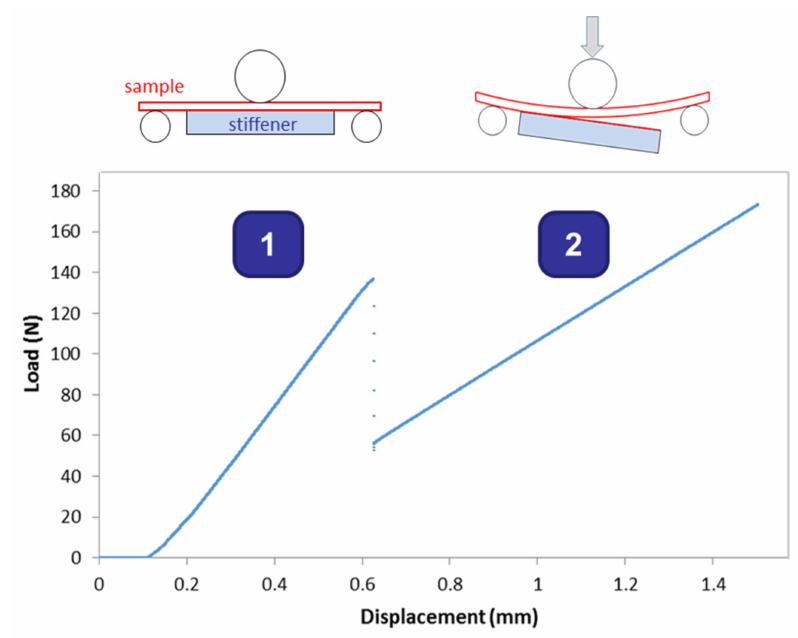
Figure 1. Bending test curve—coating critical load